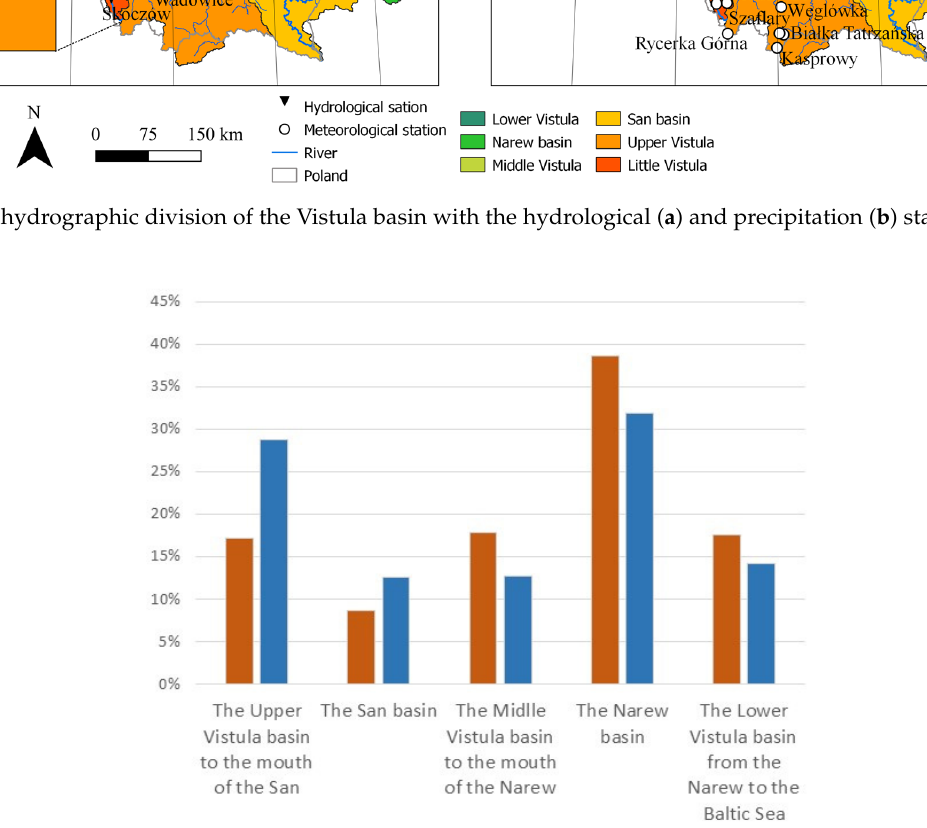
Figure 1. The hydrographic division of the Vistula basin with the hydrological ( a ) and precipitation ( b ) stations used in the study.